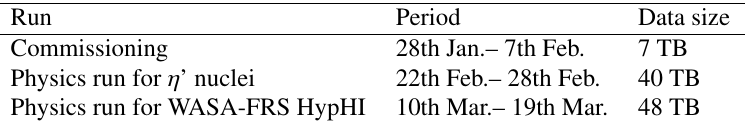
Table 1. Data obtained in the WASA-FRS experimnet.